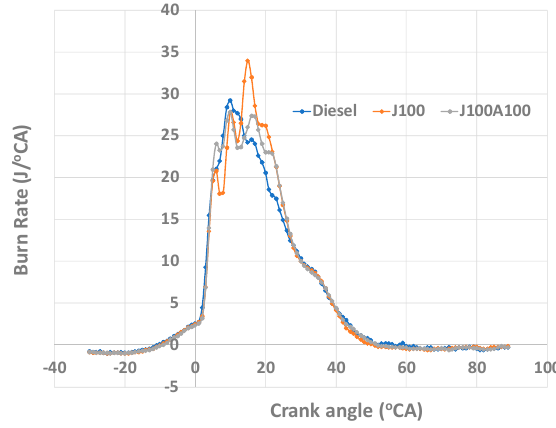
Figure 14. Heat release rate at 100% load.